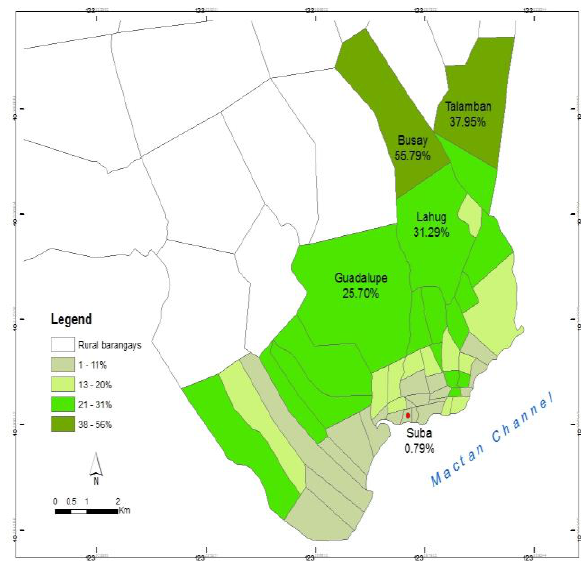
Figure 5 . Urban barangays of Cebu City with its corresponding percentage of tree canopy cover.